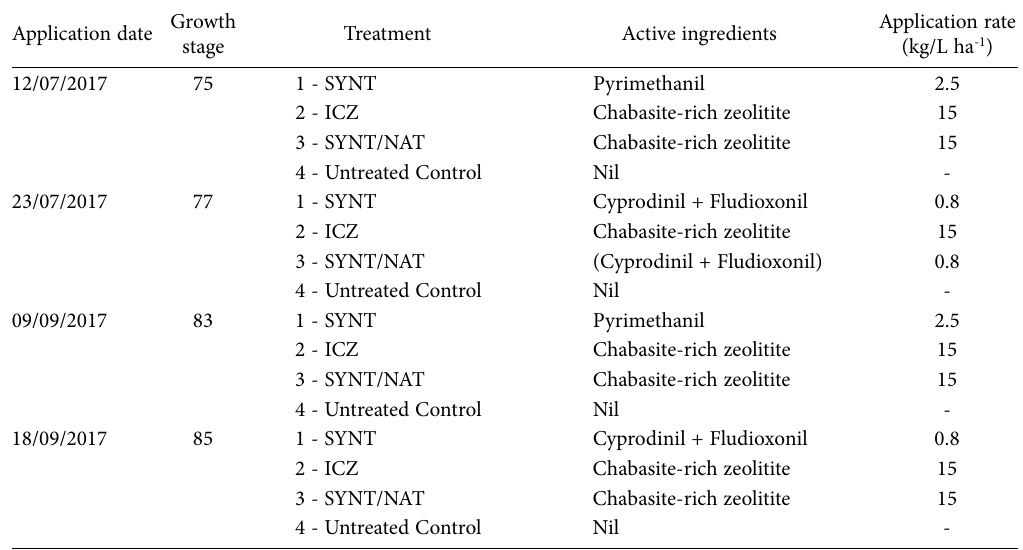
Table 2. Field applications against grey mould, sour rot and grapevine moth on cv. Montepulciano in the CSA vineyard in